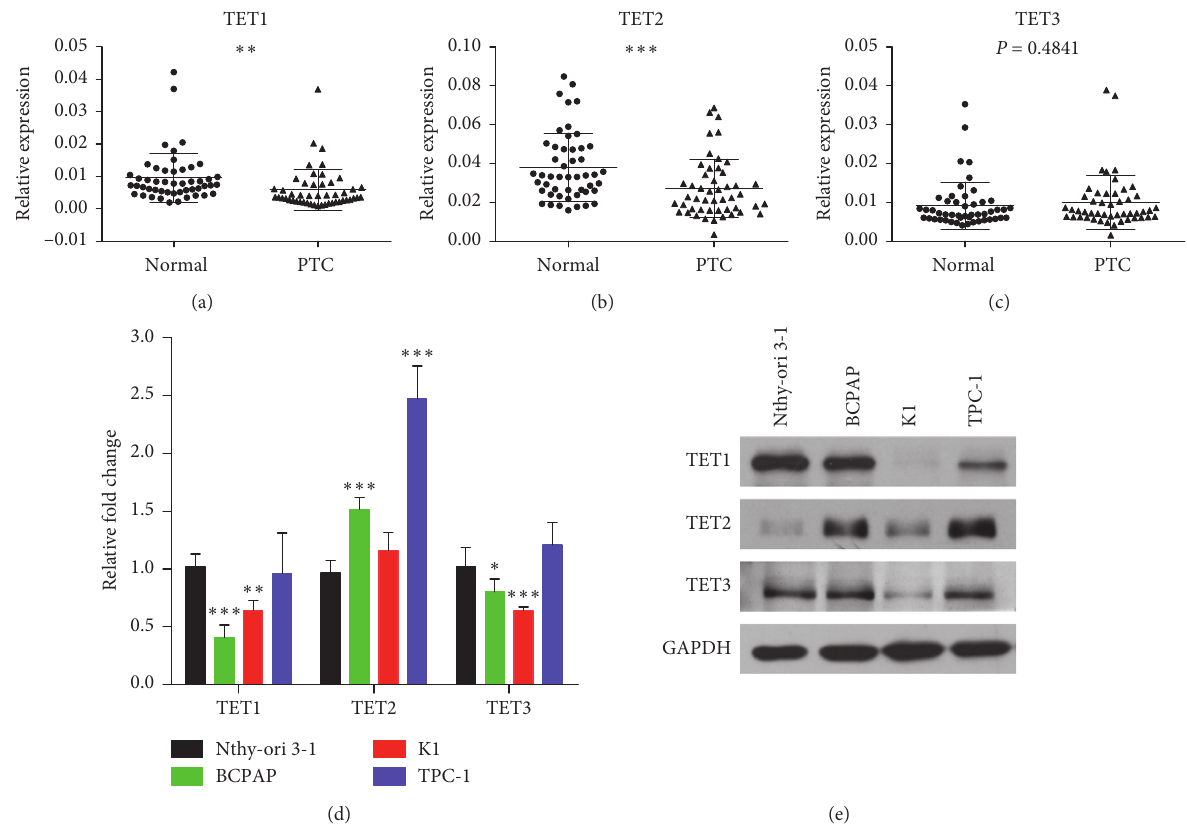
Figure 1: TETexpression in PTC tissues and cell lines. (a) Relative expression level of TET1 was downregulated in PTC tissues compared with matched normal thyroid tissues ( n � 49). (b) TET2 gene was significantly lowly expressed in PTC tissues compared with matched normal thyroid tissues ( n � 49). (c) TET3 expression was not different in PTC and matched normal thyroid tissues ( n � 49). (d) Relative expression levels of the TETfamily in PTC cell lines (BCPAP, K1, and TPC-1) compared with Nthy-ori 3-1 cells detected using qRT-PCR. (e) Expression levels of TET1 and TET3 proteins significantly decreased in PTC cells compared with Nthy-ori 3-1 cells as detected using Western blot assays. The data represented the mean ± SD from three independent experiments. ∗ P < 0 . 05, ∗∗ P < 0 . 01, and ∗∗∗ P < 0 .